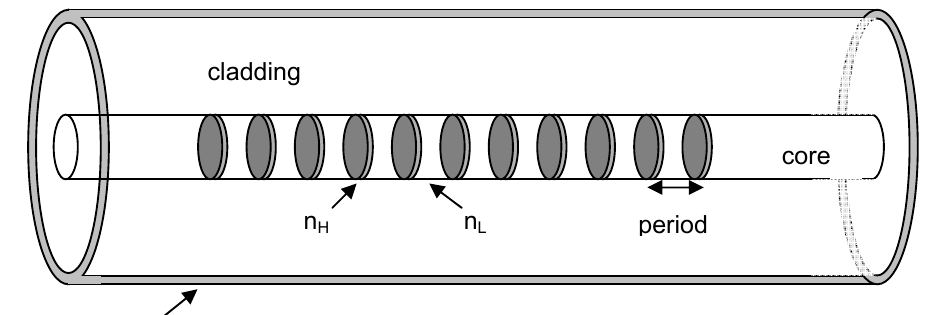
Figure 4. ESA coating onto a LPG